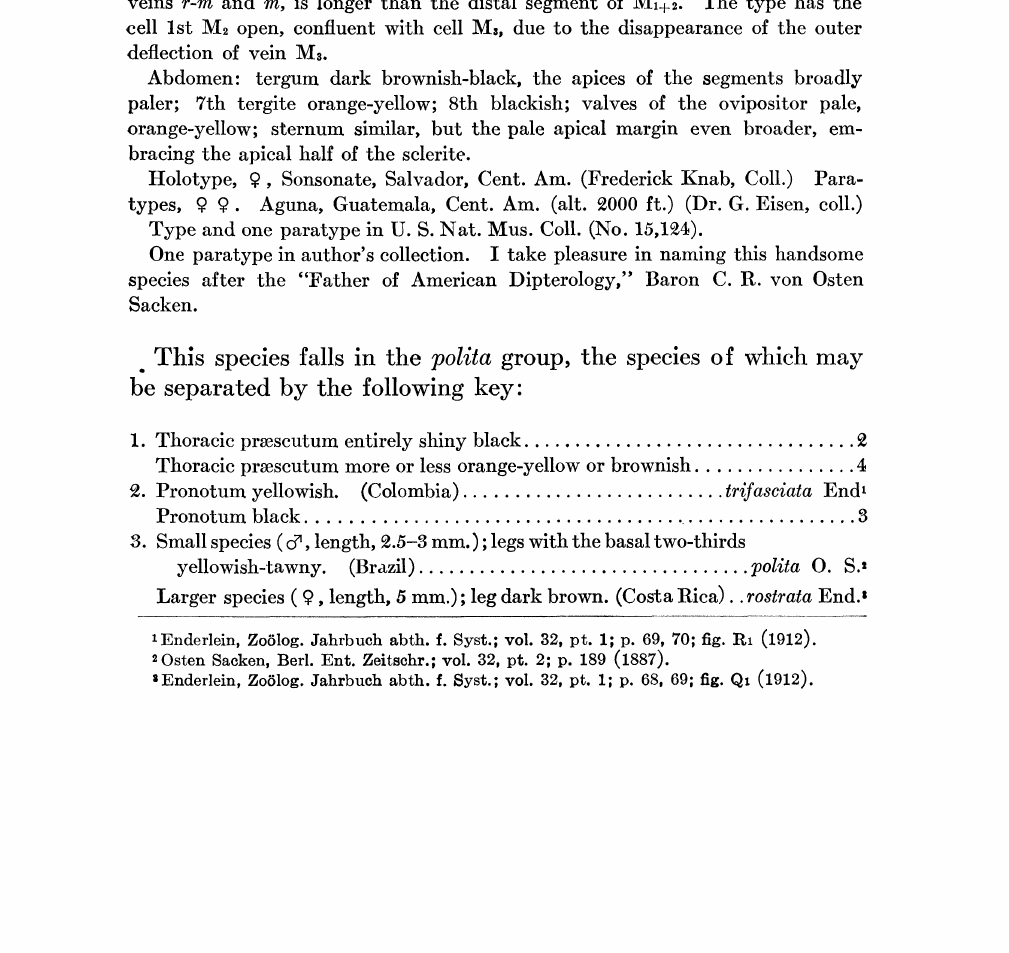
trifasciata End1